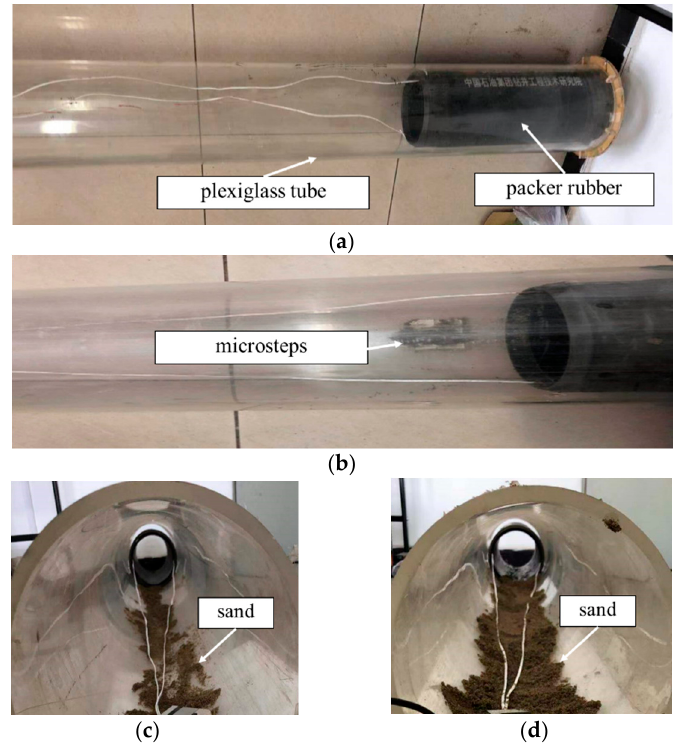
Figure 2. Schemes of the packer in the horizontal open hole: ( a ) In a clean and smooth hole; ( b ) in a hole with microsteps; ( c ) in a hole with little cuttings; and ( d ) in a hole with lots of cuttings.